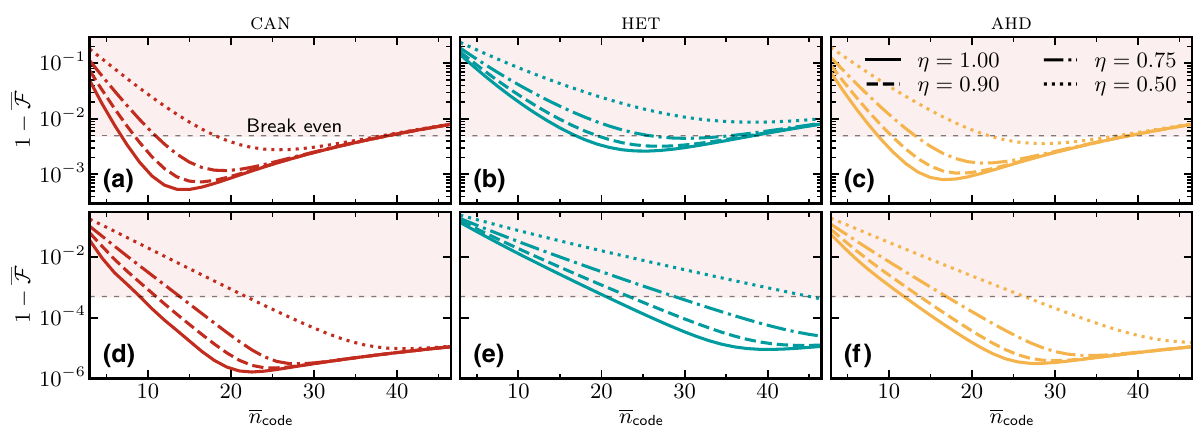
FIG. 8. Average gate infidelity for the telecorrection circuit (Fig. 2) with inefficient measurement models. Before error correction is applied the initial state is subject to noise of total strength κτ = κ φ τ = 1 × 10 − 2 in panels (a)–(c) (top row) and κτ = κ φ τ = 1 × 10 − 3 in panels (d)–(f) (bottom row). Each column shows a different realization of the phase measurement. The figure shows the results for order N = 3 bin codes that are defined only for discrete n code values. Continuous lines are shown to improve readability. Error correction with RSB codes is beneficial whenever the infidelity falls below the dashed line that indicates the break-even point.